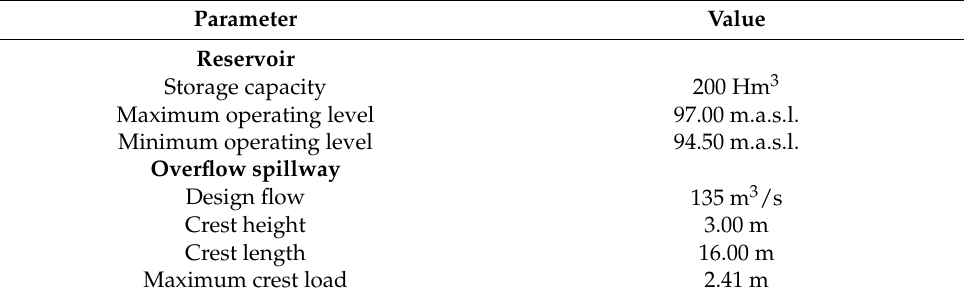
Table 2. Design parameters of the Sube y Baja dam components.